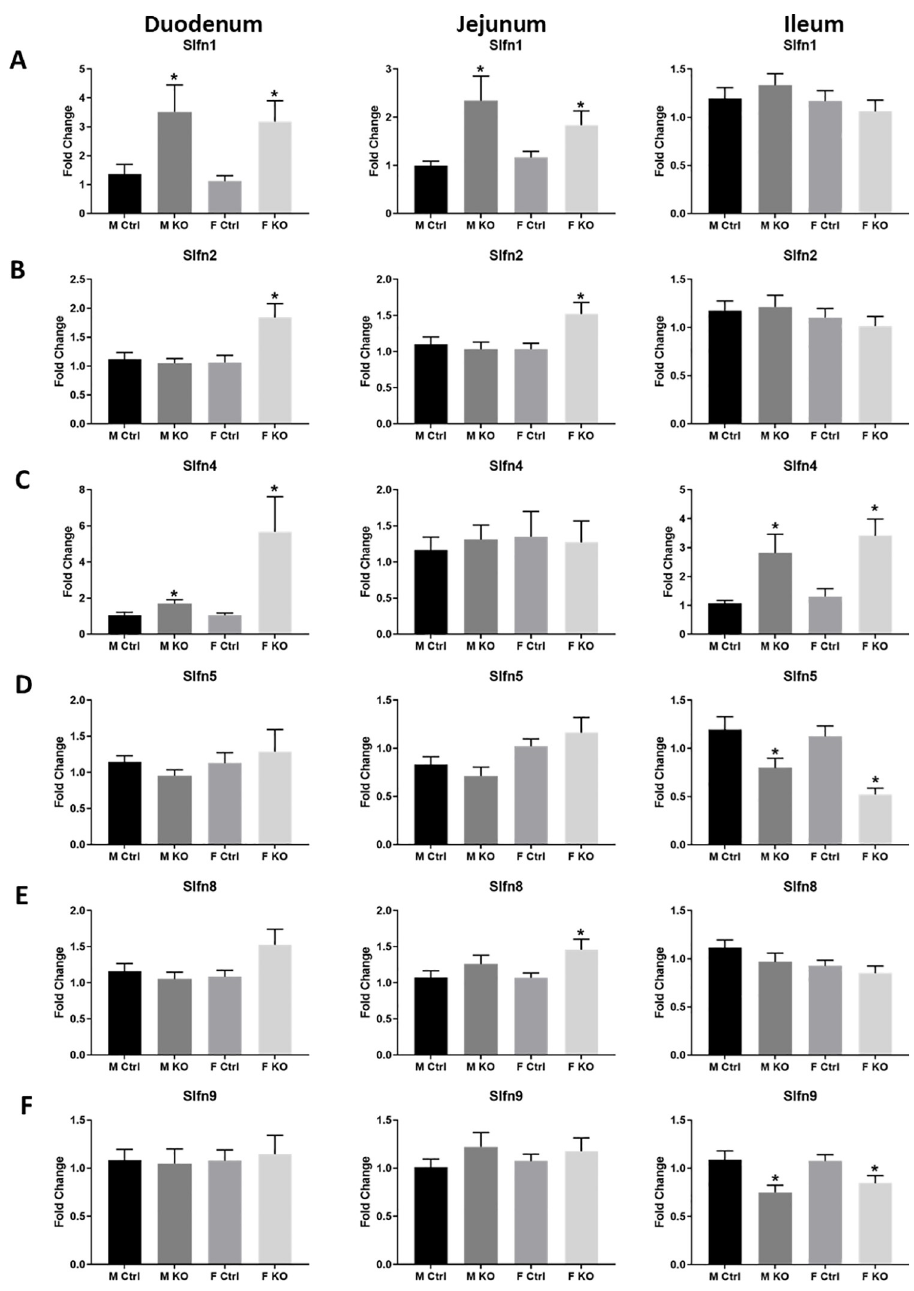
Fig 4. Slfn family expression changes based on intestinal epithelial specific loss of Slfn3, intestinal region, and sex. Total RNA was isolated from intestinal mucosa of the duodenum, jejunum, and ileum of control (Ctrl) and VC-Slfn3KO (KO) mice. The mRNA expression of (A) Slfn1, (B) Slfn2, (C) Slfn4, (D) Slfn5, (E) Slfn8, and (F) Slfn9 was analyzed by qPCR using RPLP0 as a reference control gene. (n = 9–48, � p < 0.05 to respective Ctrl). significant change in SI protein levels compared to Ctrl mice. However, female VC-Slfn3KO mice had significantly less SI protein in jejunal enterocytes compared to Ctrl mice (Fig 5D and 5E). The CD3 + SI + immune cells were evaluated as well, and we found that there was a decrease in SI protein in the duodenum of female VC-Slfn3KO mice (S4 Fig).